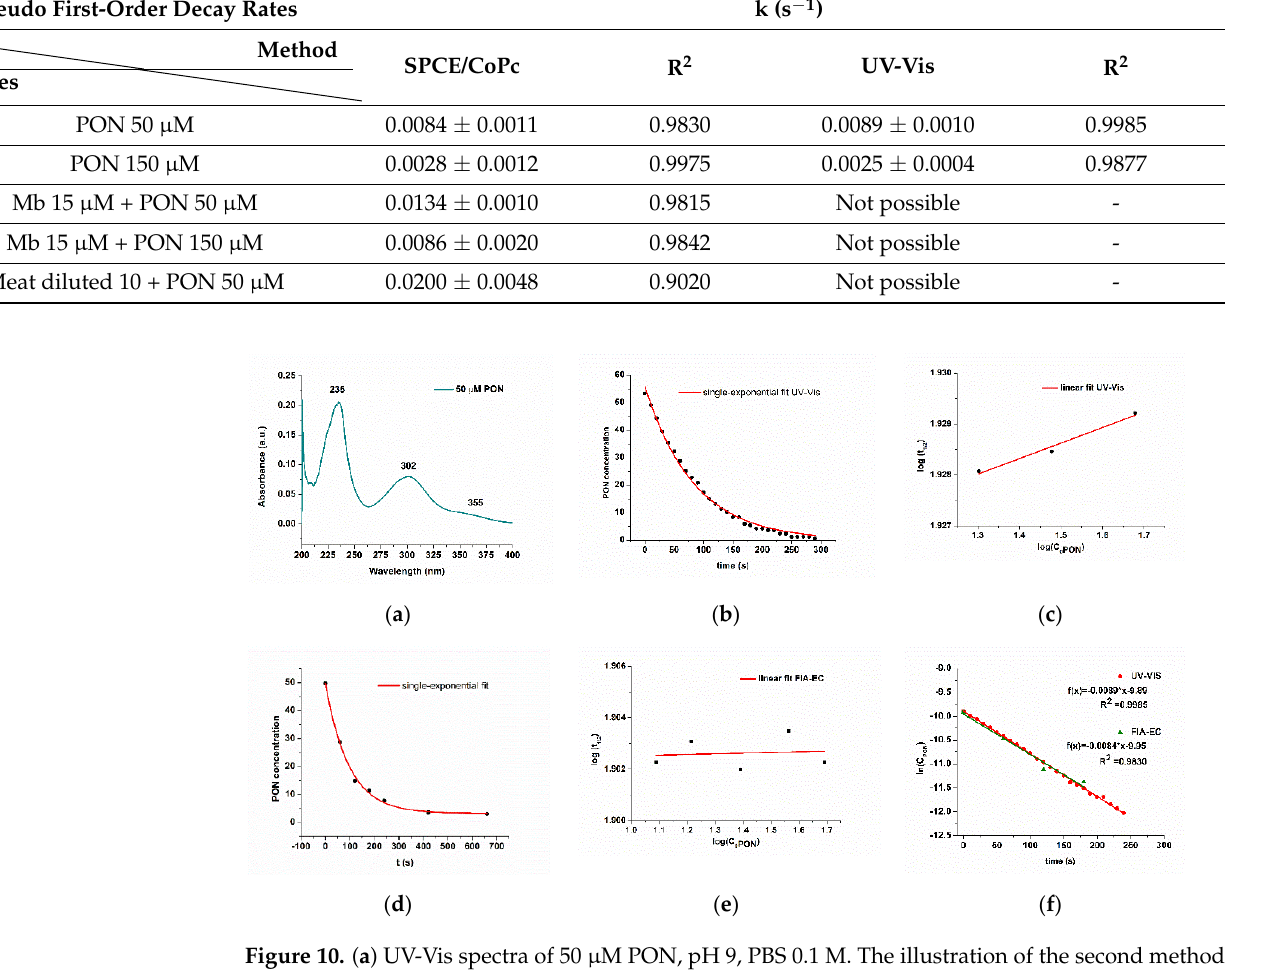
Table 2. Calculated pseudo first-order decay rates constants for PON, in PBS pH 9 (0.1M), at 25 ◦ C, determined using classical UV-Vis method at 302 nm and the FIA-EC method, using the SPCE/CoPc (Method A). Pseudo First-Order Decay Rates